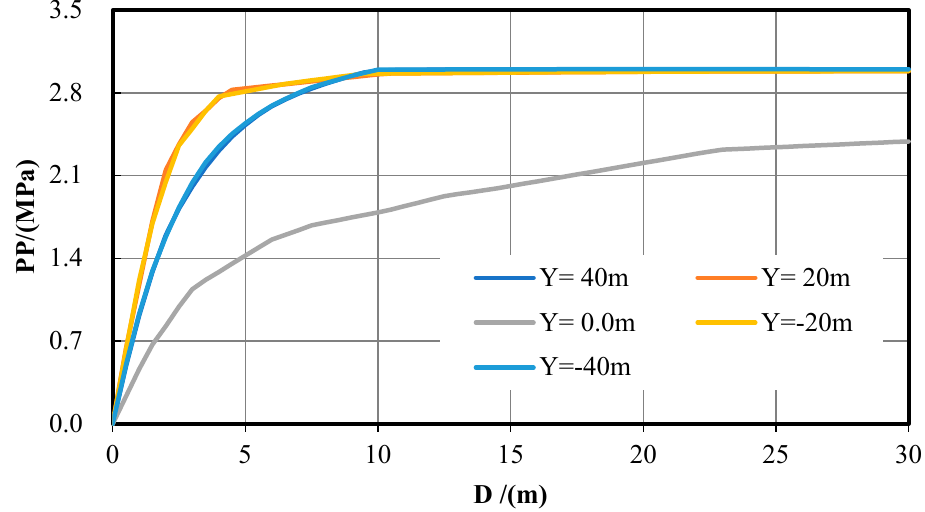
Figure 12. PP as a function of D with various relative positions. It can be obtained from Figure 12 that pore pressures at the Y = ± 40 m and Y = ± 20 m sections are very similar. Within 10 m range ahead of the tunnel face, fluid pressure flows are P Y = 20 = P Y = − 20 > P Y = 40 = P Y = − 40 > P Y = 0 . In summary, when the fault intersection is in Y = ± 40 and Y = ± 20, the surrounding rock near the tunnel face has low permeability, which has little effect on the water pressure around the excavation face. Due to the stress release during the tunnel excavation progress, a low-pressure region is formed near the excavation face, which has a more significant influence on the distribution of pore pressure in the tunnel-surrounding rock than the influence of the two overlapped intersecting faults. We select the flow velocity at each point from the survey lines in the center of the excavation face (Y = 0 m) to obtain the flow velocity curves, as shown in Figure 13. The flow velocity magnitude follows the order of U Y = 0 > U Y = 20 = U Y = − 20 > U Y = 40 = U Y = − 40 . When the tunnel approaches the fault intersection, the flow velocity increases by orders of magnitude, reflecting that the distance to the fault intersection significantly impacts the fluid flow velocity in the tunnel-surrounding rock. The water inflow rate around the excavation face and the total water inflow rate into the tunnel are shown in Table 3 and Figure 14. It has been found that when the fault intersection center position is at Y = 0, the inflow rate value is the largest, and when the fault intersection center position is at Y = ± 40 m and Y = ± 20 m, the water inflow rates are the same. It shows that the relative vertical location of the intersecting faults has little effect on the flow